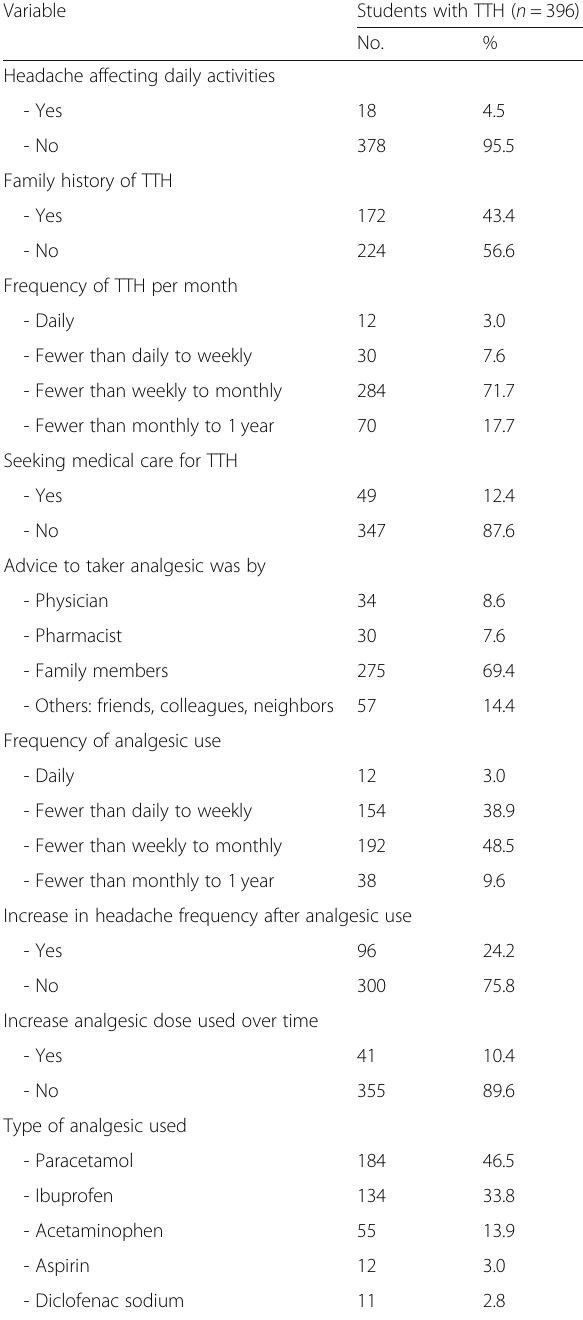
Table 3 Distribution of participants with TTH according to tension headache characteristics, Taif University, KSA, 2017 Variable Students with TTH ( n =